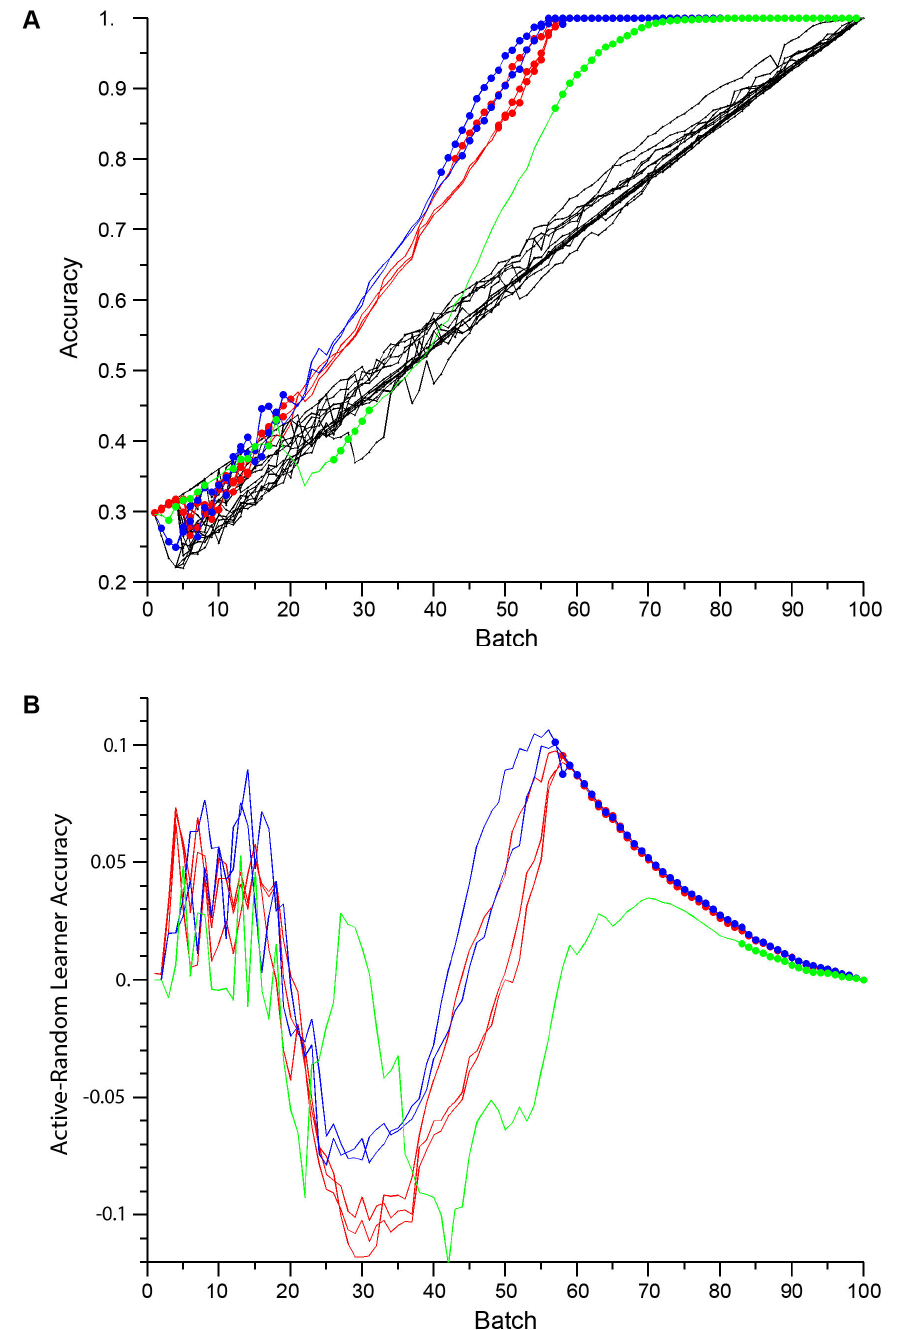
Figure 2. Learning performance dependence on model design: structure learning and imputation rule choice. (A) Each model design was evaluated with both active and random learners on two simulated 100 target x 100 condition datasets, each having eight phenotypes, 80% responsiveness and 40% uniqueness. For each model design the best average accuracy for either the active or random learner is plotted at each batch. For six cases displaying superlinear performance, structure learning methods are indicated in color, with different design variations plotted as separate lines and with filled circles to indicate batches where the active learner had higher accuracy: Greedy Merge (blue), a ‘strict’ variation of Greedy Merge (red), and B-Clustering (green, one design). These each had both Target Equivalence Class and Three-Point Imputation rules. (B) The difference in random and active learner accuracies for the superlinear model designs with structure learning method plotted by color as above; filled circles at tails indicate that the active learner had reached 100% accuracy. doi: 10.1371/journal.pone.0083996.g002 PLOS ONE |